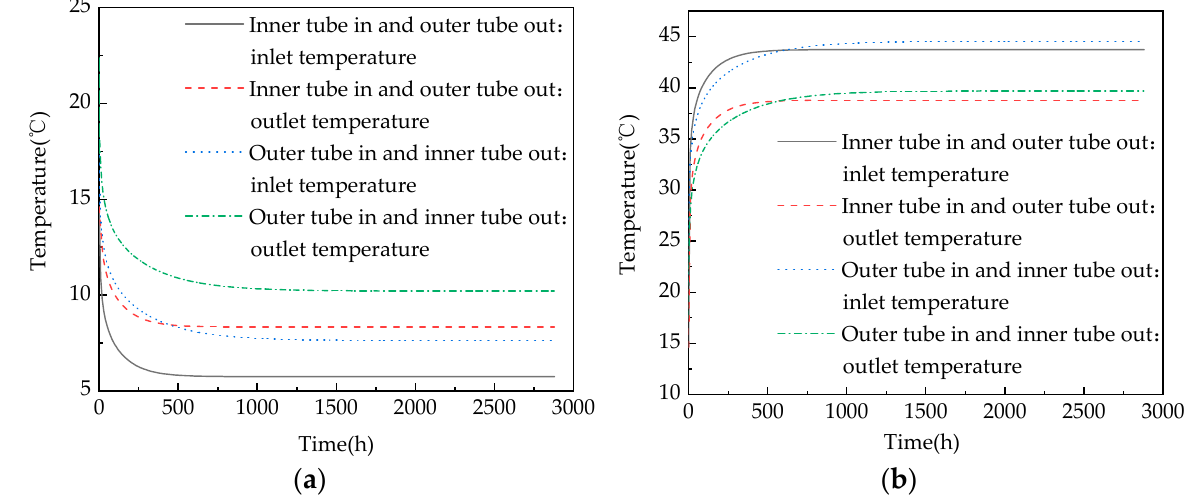
Figure 3. Changes in the inlet and outlet temperatures under different circulation modes. ( a ) Changes in the inlet and outlet temperatures in winter. ( b ) Changes in the inlet and outlet temperatures in summer.